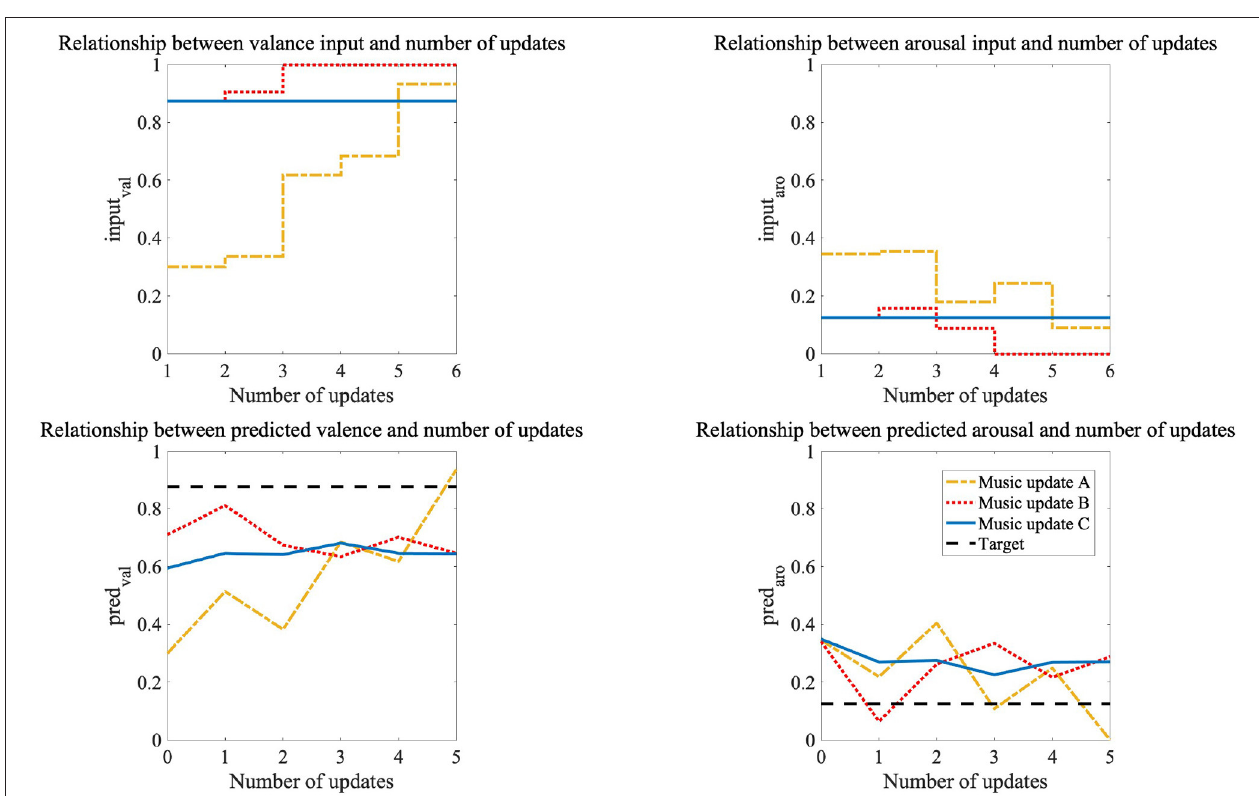
FIGURE 8 | Plots of inputs of music generator and emotions predicted from CNN and neural network in participant eight: Target emotion is {val,aro} = {0.875,0.125}.